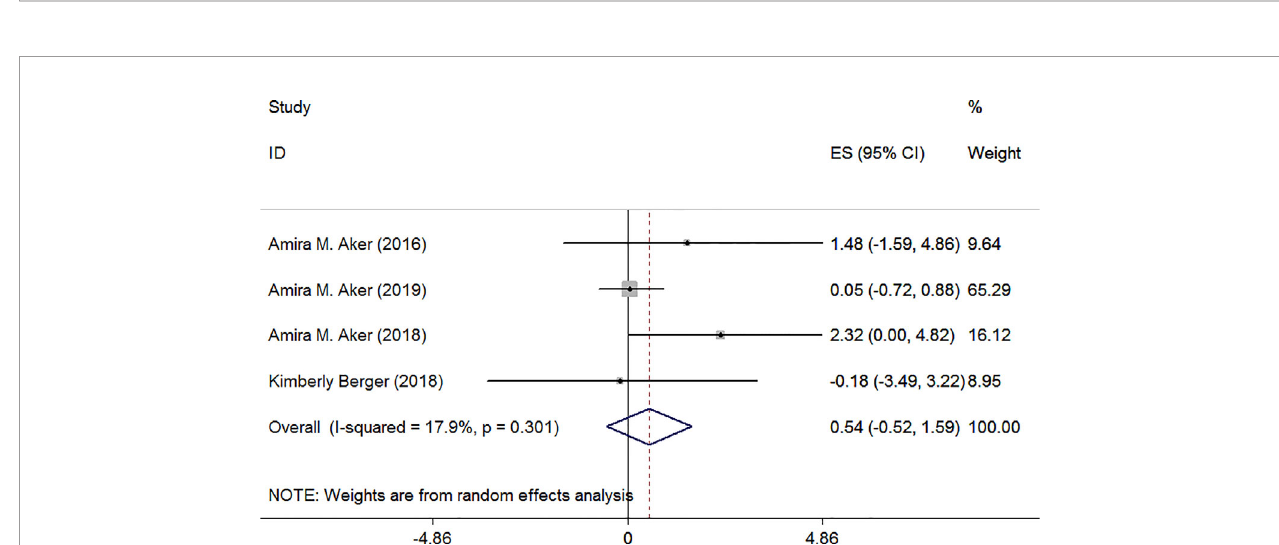
FIGURE 7 | Forest plot of prenatal exposure to TCS and maternal TSH levels standardized using speci fi c gravity.